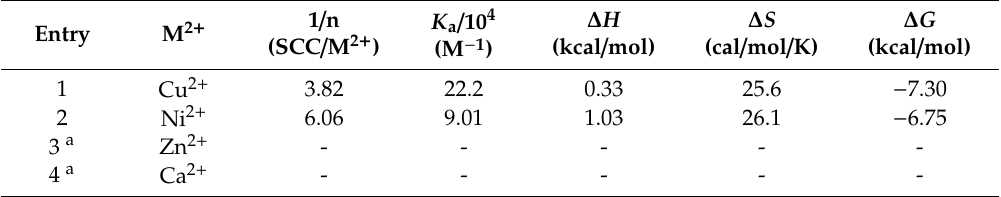
Table 1. Thermodynamic parameter of SCC / M 2 + complexation in water at 25 ◦ C.